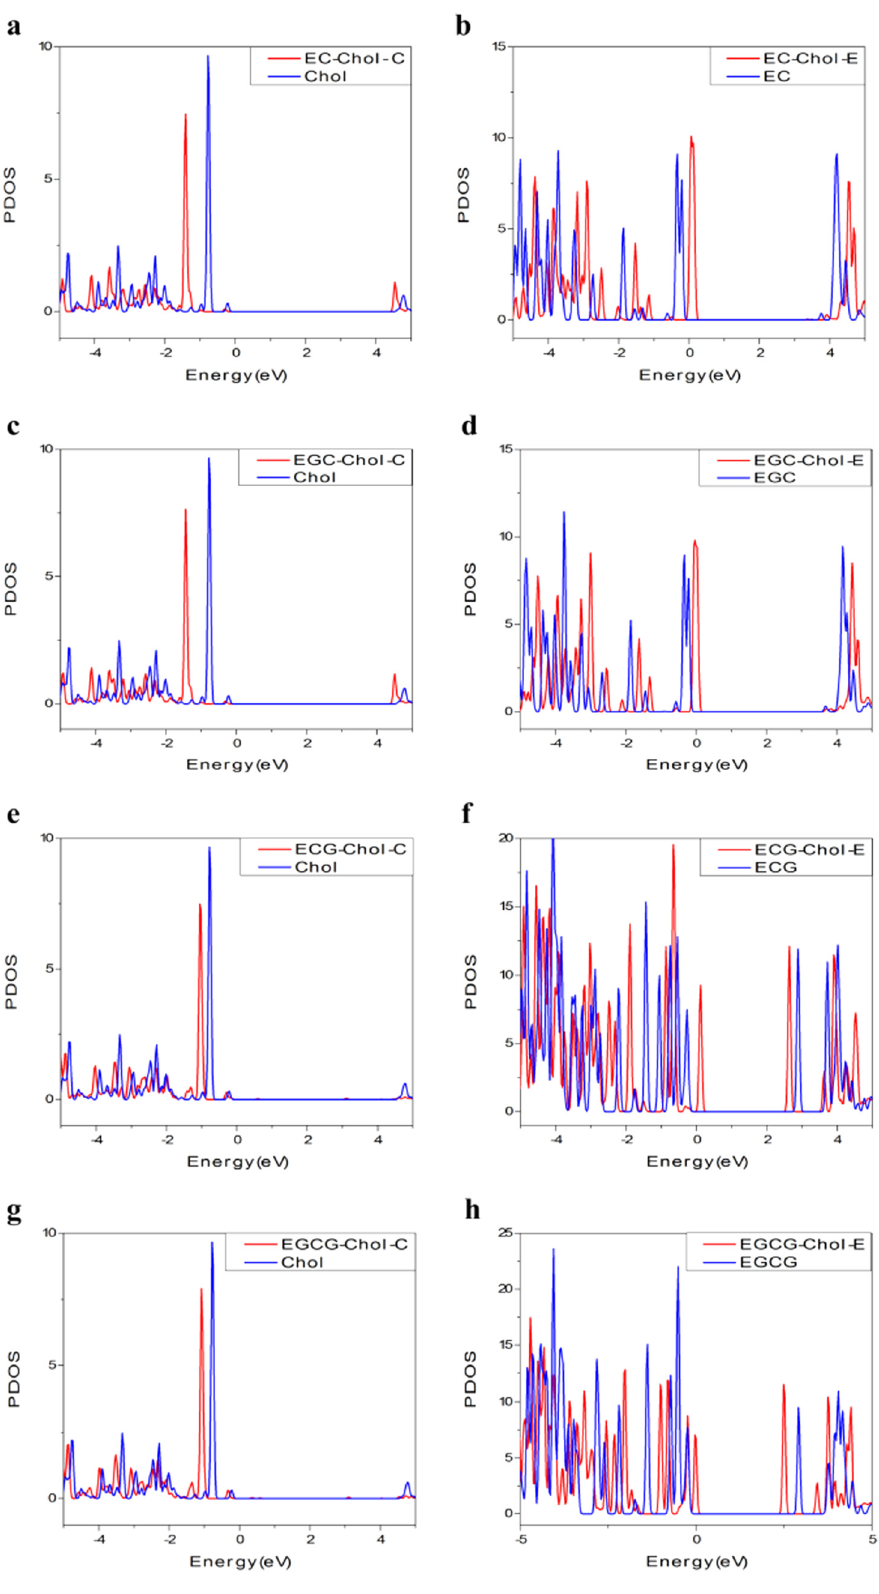
Figure 7: Partial density of the interacting atoms on complexes ( catechin – Chol - E represents the active atoms on catechin of catechin – Chol complexes, catechin – Chol - C represents the active atoms on cholesterol of catechin – Chol complexes, Chol represents the active atoms on only cholesterol and EC/EGC/ECG/EGCG represents the active atoms on only catechin )